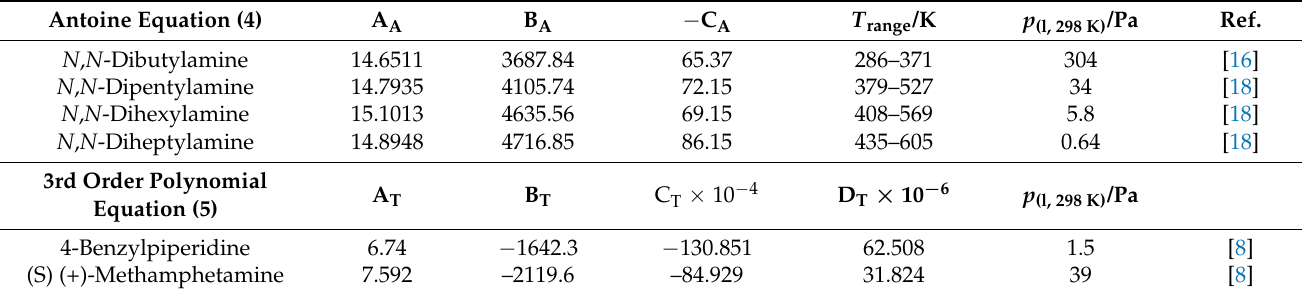
Table 3. Constants for the Antoine equation (and of a third order polynomial; p o = 101,325 Pa).